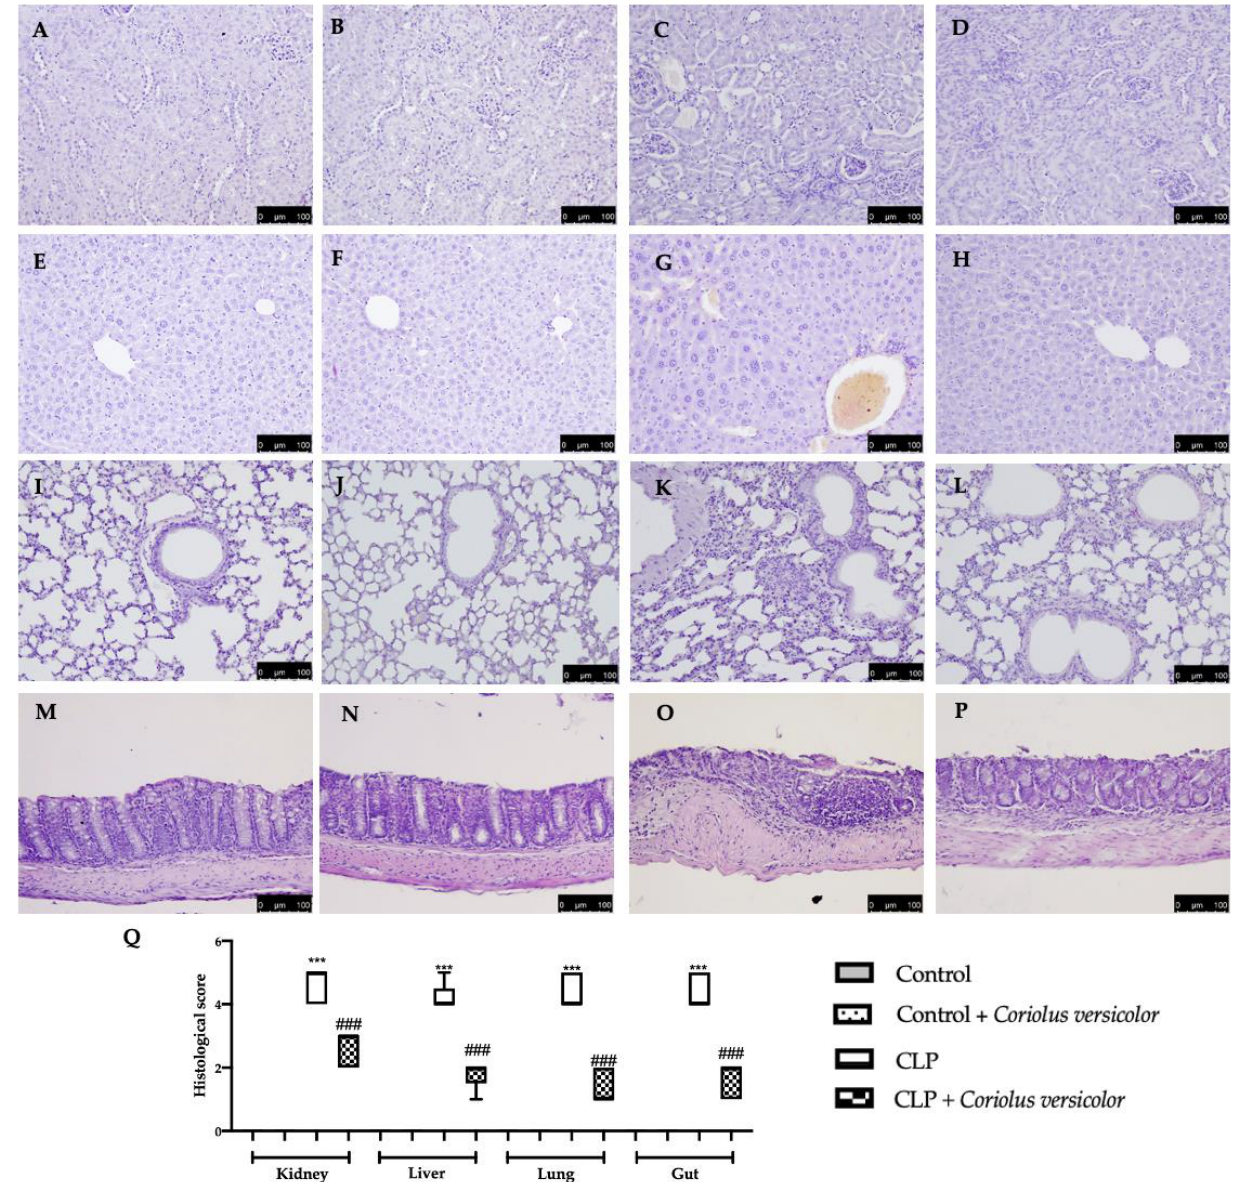
Figure 2. Coriolus versicolor reduced histological damage induced by CLP 72 h after surgery. Hema- toxylin and eosin staining of: kidney: Control ( A ), Control + Coriolus versicolor ( B ), CLP ( C ), CLP + Coriolus versicolor ( D ); liver: Control ( E ), Control + Coriolus versicolor ( F ), CLP ( G ), CLP + Coriolus versicolor ( H ); lungs: Control ( I ), Control + Coriolus versicolor ( J ), CLP ( K ), CLP + Coriolus versicolor ( L ); gut: Control ( M ), Control + Coriolus versicolor ( N ), CLP ( O ), CLP + Coriolus versicolor ( P ); histological score ( Q ). *** p < 0.001 vs. Control, ### p < 0.001 vs. CLP.